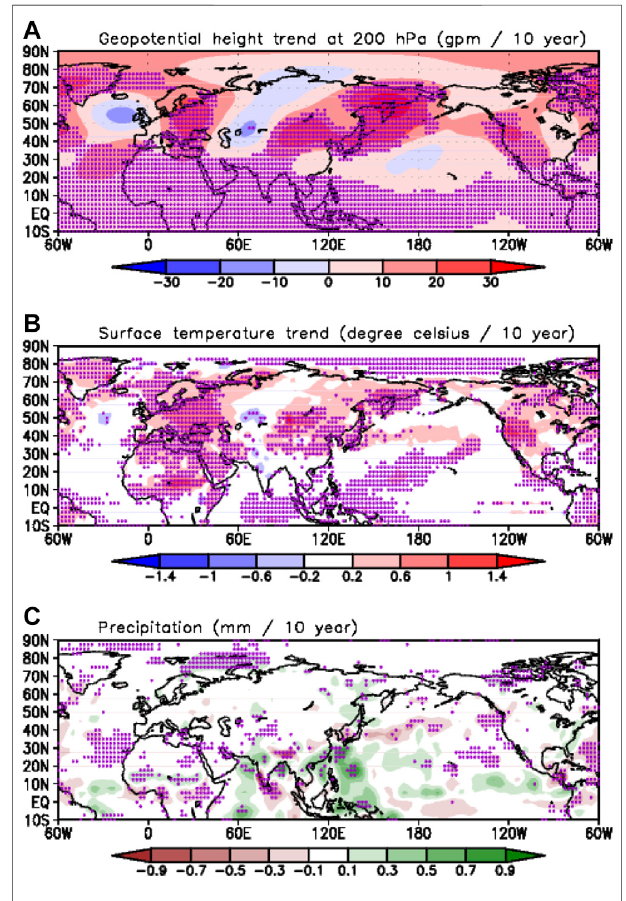
FIGURE 10 | Linear trend of (A) geopotential height at 200 hPa, (B) surface temperature, and (C) precipitation (1979 – 2018). The nonparametric Mann – Kendalltestisusedtoevaluatewhetherthereisastatisticallysigni fi cant linear trend in the time series at each grid point. Dots denote the signi fi cant regions at the 95% con fi dence level.